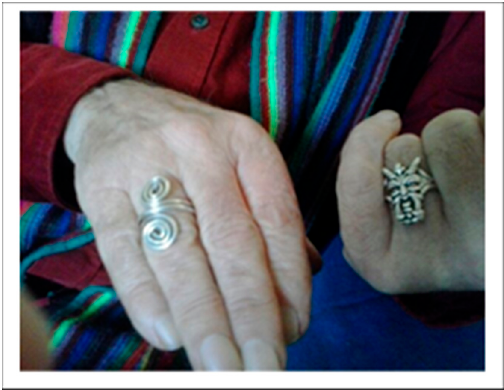
Figure 4. Photograph taken by Jac’s friend of his symbolic jewellery.